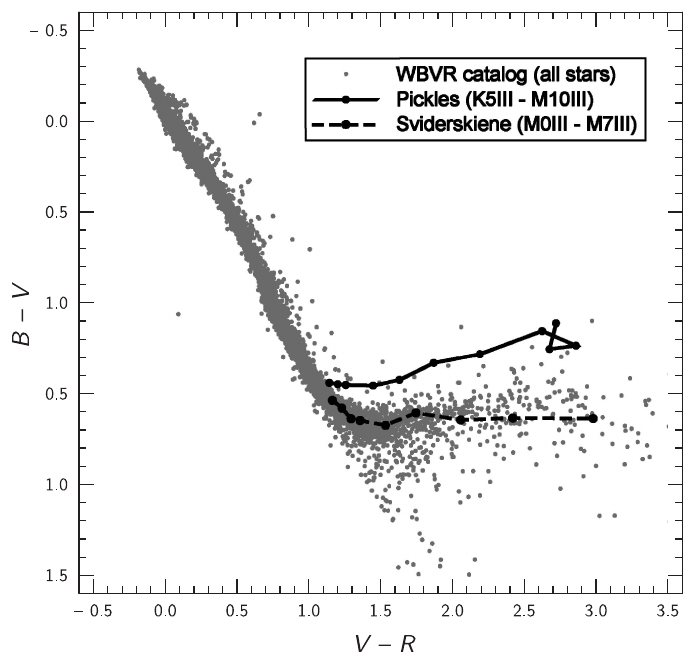
Fig. 5. Synthetic B; V; R photometry, calculated from Pickles (1998) and Svider- skiene (1988) data for red giants, together with observational data from the WBV R catalogue (Kornilov et al.